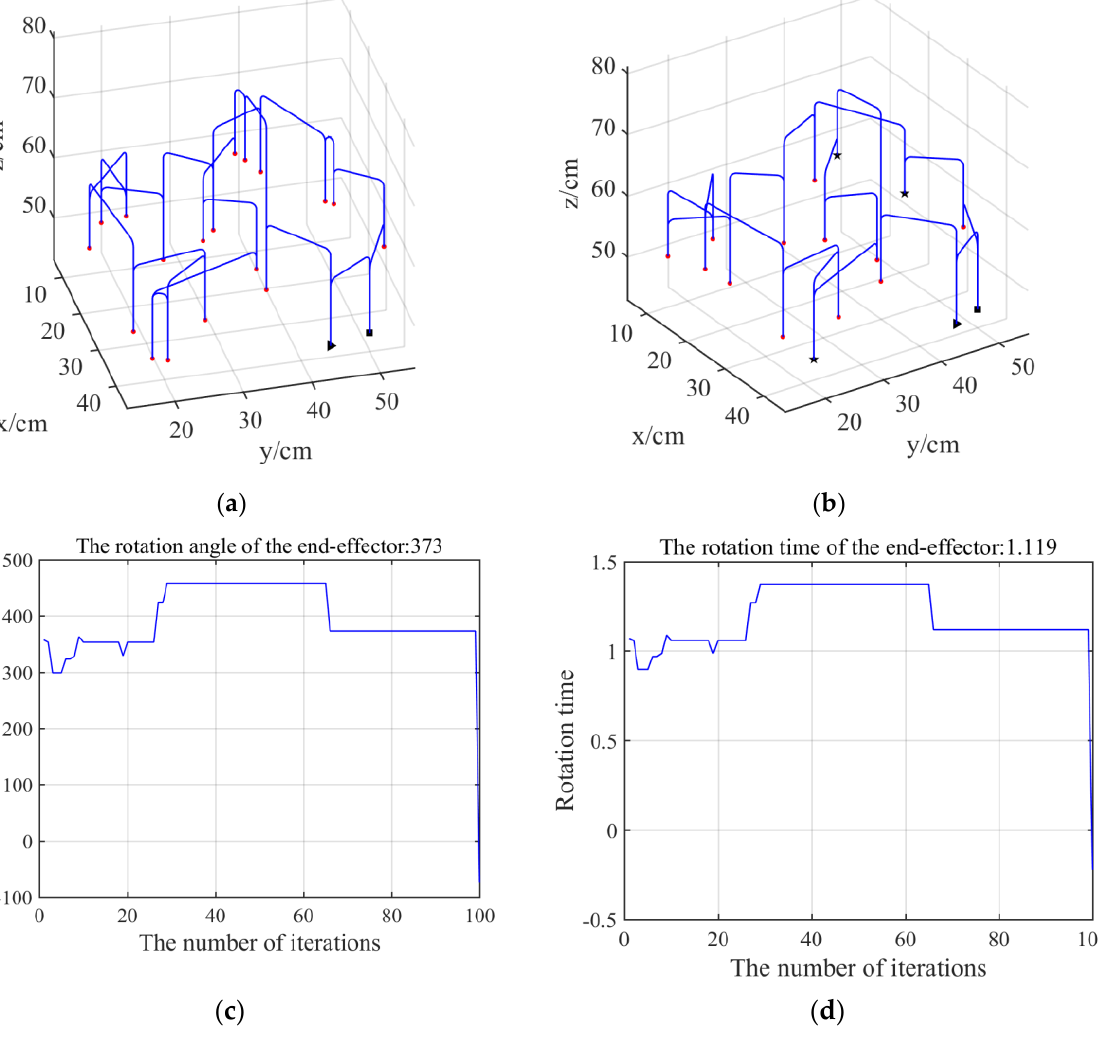
Figure 17. Improved ACA planning results: ( a ) Optimal picking path from initial path planning; ( b ) Result of secondary path optimization; ( c ) Path length change curved; ( d ) Sum of waiting times of shortest paths.